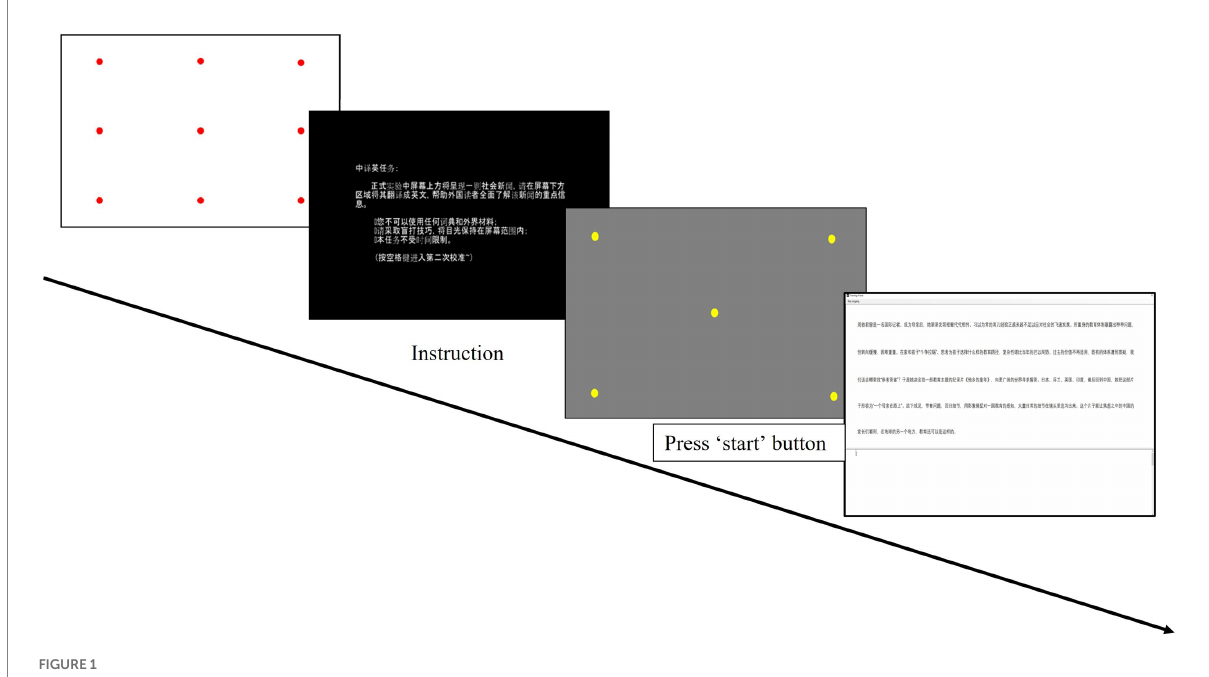
FIGURE 1 The experimental procedure in one